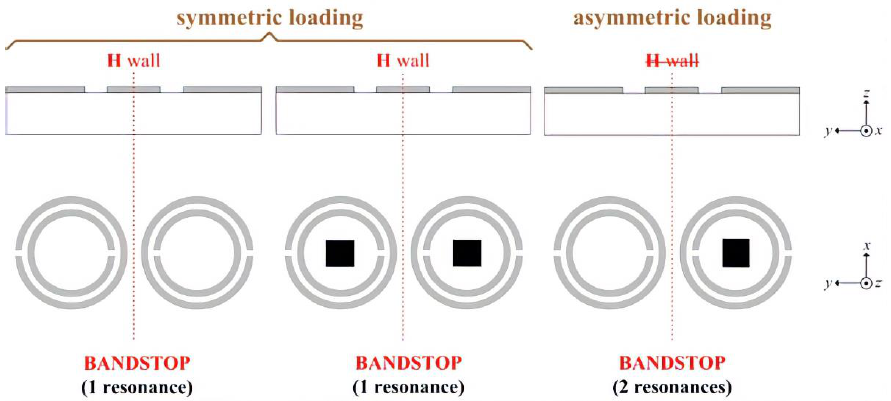
Figure 21. Illustration of frequency splitting through symmetry imbalance (considering square-shaped inclusions) in a CPW symmetrically loaded with a pair SRRs. From [47], reprinted with permission.